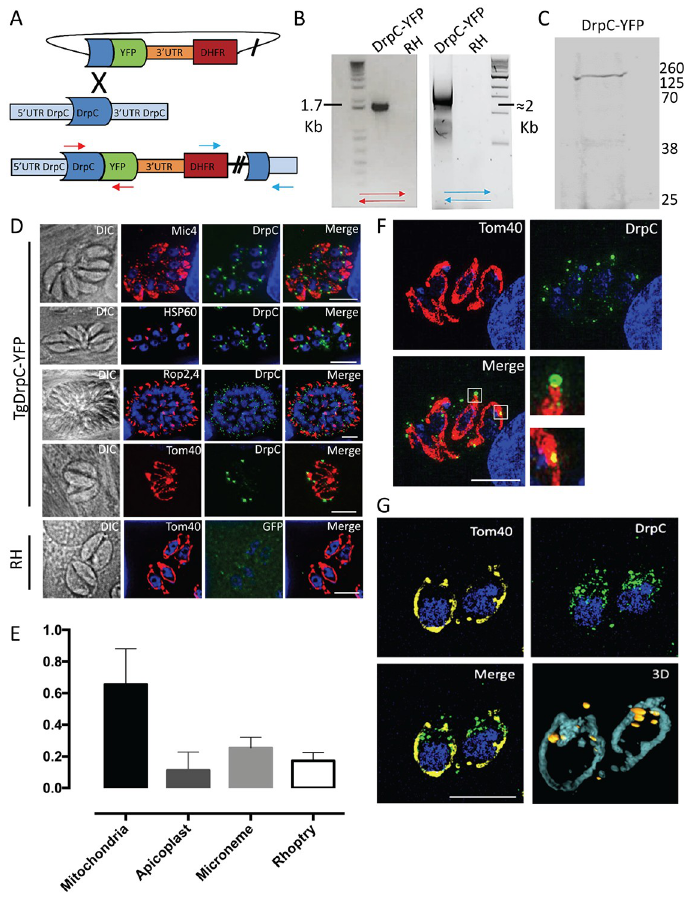
Fig 3. Endogenous tagging of Tg DrpC reveals a mitochondria localisation. (A) Strategy for the endogenous tagging of Tg DrpC with YFP in RH Δ ku80 parasite strain: The ligation-independent cloning vector LIC-YFP was integrated at the 3’ end of Tg DrpC, through a single-crossover mechanism. (B) PCR analyses using the primers indicated in (A) confirms the integration of the tagging construct at 5’ and 3’ ends. (C) Western blot analysis using α -GFP antibody on the Tg DrpC-YFP clonal line verifies the expected protein size of � 160 kDa. (D) Immunofluorescence images showing the co-localisation between Tg DrpC and the indicated organelles (Mic4, micronemes; HSP60, apicoplast; Rop2-4, rhoptries; Tom40, mitochondrion). (E) Quantification of colocalisation between Tg DrpC and the indicated organelles; the Manders’ coefficient (average of n > 20 values) is reported in the y axis. (F) Tg DrpC puncta (green) have different shapes and sizes, varying from spirals to smaller dots on the membrane; 3-D reconstruction (G) confirms that the vast majority of Tg DrpC aggregates are in close proximity with mitochondria. Scale bar: 5 μ m.